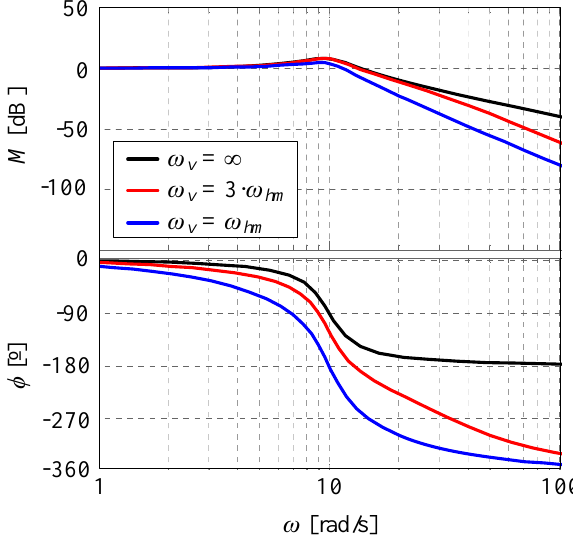
Figure 2: Block diagram representation of hydraulic servo system controlling a single DOF.